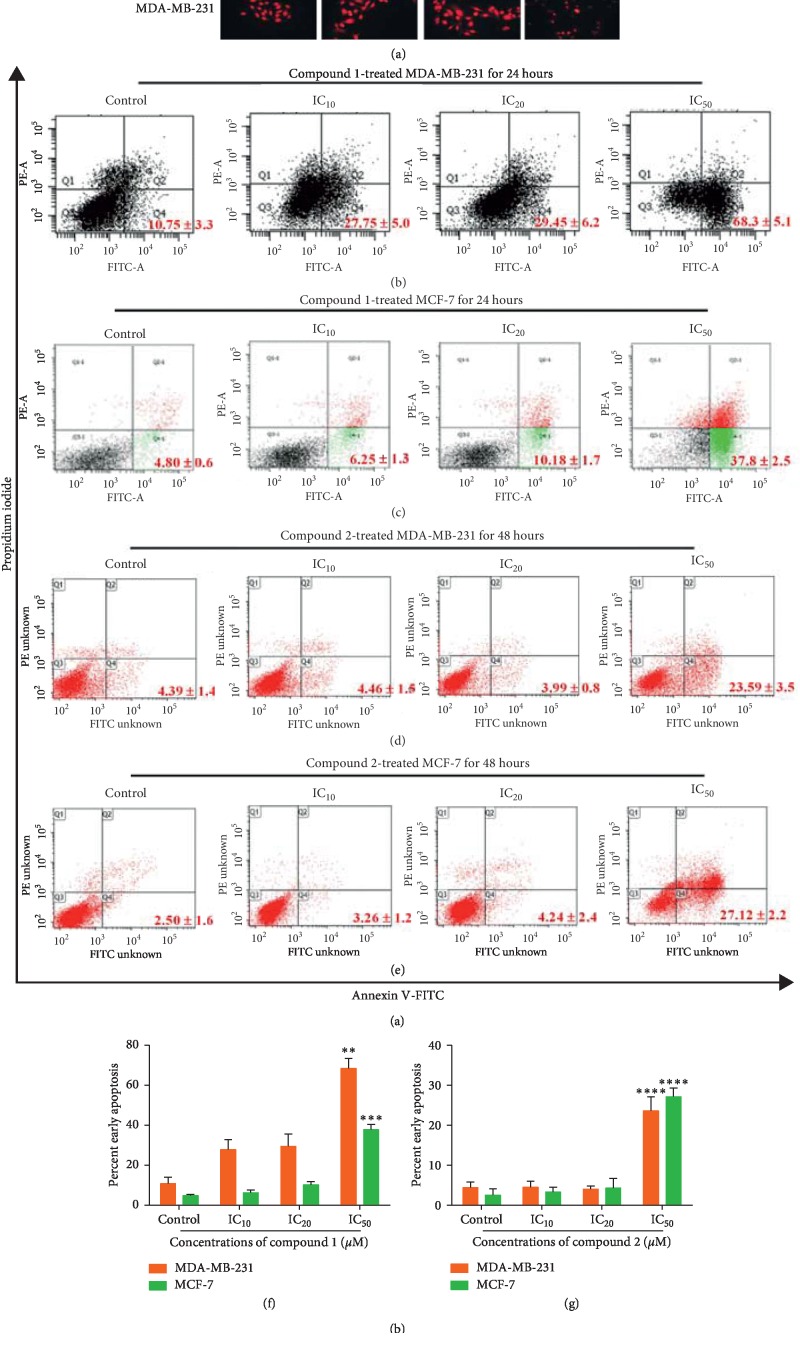
Apoptosis induced by dihydrochalcone derivatives. Cell morphology of apoptotic cells exhibited as condensed nuclei and apoptotic bodies (white arrows →) after compound 1 treatment for 24 hours and then staining with propidium iodide (PI) and examining under a fluorescence microscope (a). Apoptotic cells were treated with dihydrochalcone derivatives for 24 hours and then stained with annexin V-FITC and PI employing a flow cytometer as demonstrated by dot plots of MDA-MB-231 cells (b) and MCF-7 cells (c) and were treated with compound 2 for 48 hours in the MDA-MB-231 cells (d) and MCF-7 cells (e). Bar graphs of percent cells in early apoptosis of both types of cancer cells after compound 1 (f) and compound 2 (g) treatments are presented. ∗∗p < 0.01, ∗∗∗p < 0.001, and ∗∗∗∗p < 0.0001.